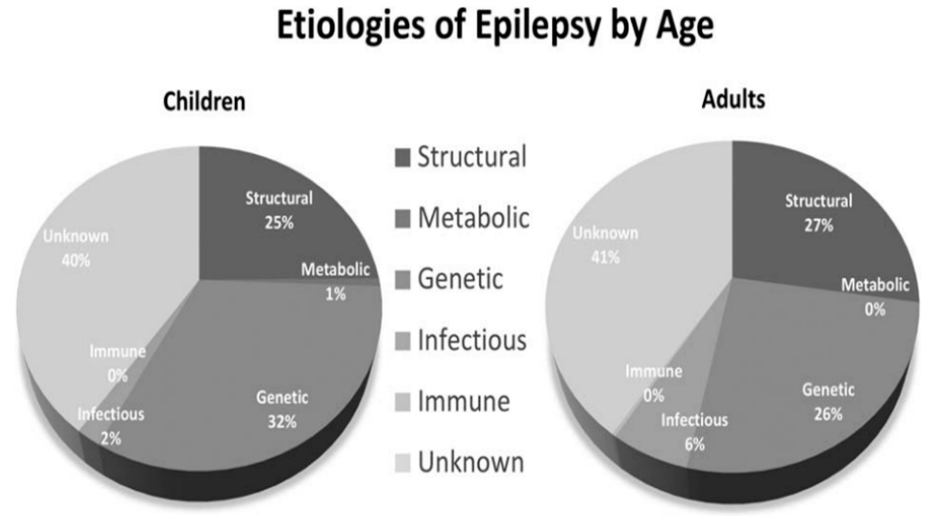
Figure 1. Etiologies of epilepsy by age.